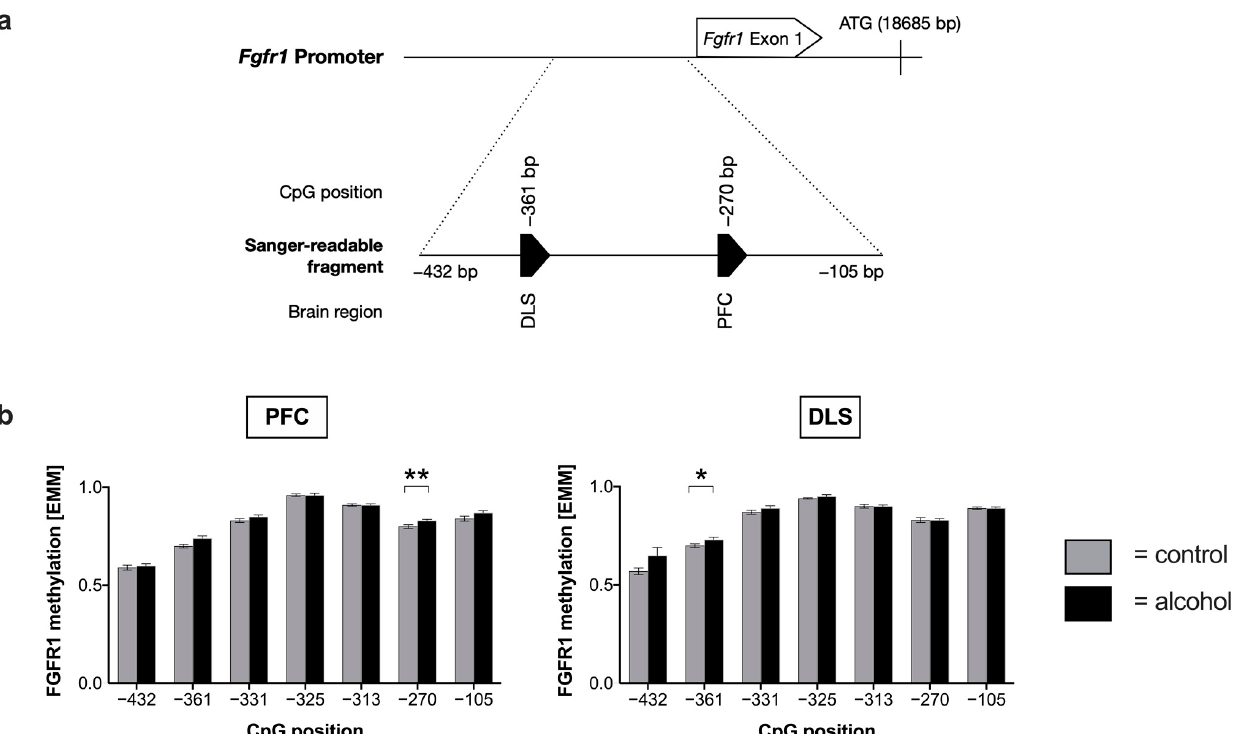
Figure 3. Alterations in fibroblast growth factor receptor 1 ( Fgfr1) methylation after alcohol